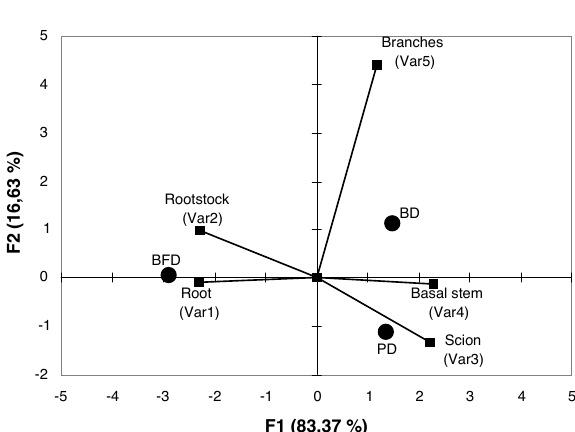
Figure 2. Principal component analysis based on isolation frequencies (IFs).